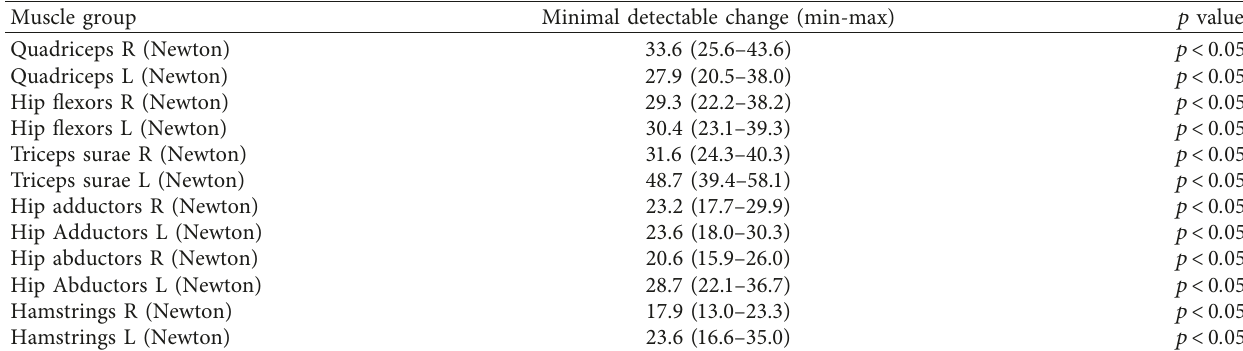
Table 4: Minimal detectable change